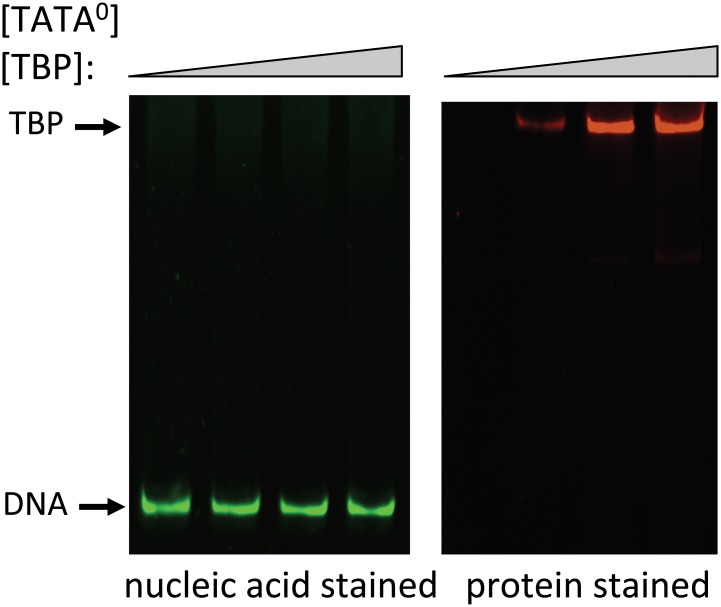
Control EMSA experiments showing no gel shift in reaction mixtures containing purified BbTBP and a TATA-less oligonucleotide.Reaction mixtures containing TATA0 template (16 nM) with increasing concentrations (0, 280, 1120, and 1960 nM) of BbTBP, were resolved on 6% non-denaturing SDS-PAGE and analyzed as detailed in the Experimental procedures section. Left panel visualized with nucleic acid stain (green), right panel, protein stain (red).